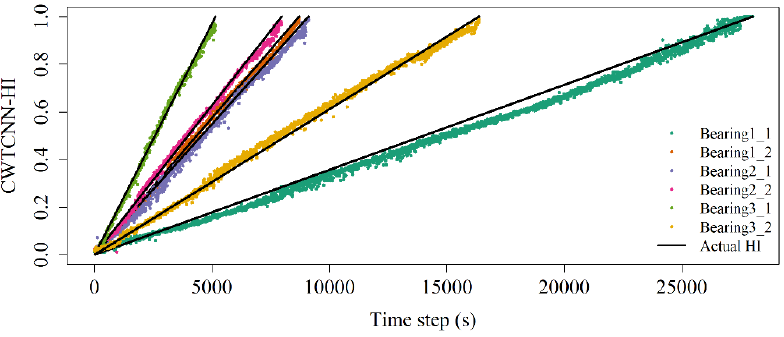
Figure 8. CWTCNN-HI of the six training datasets.